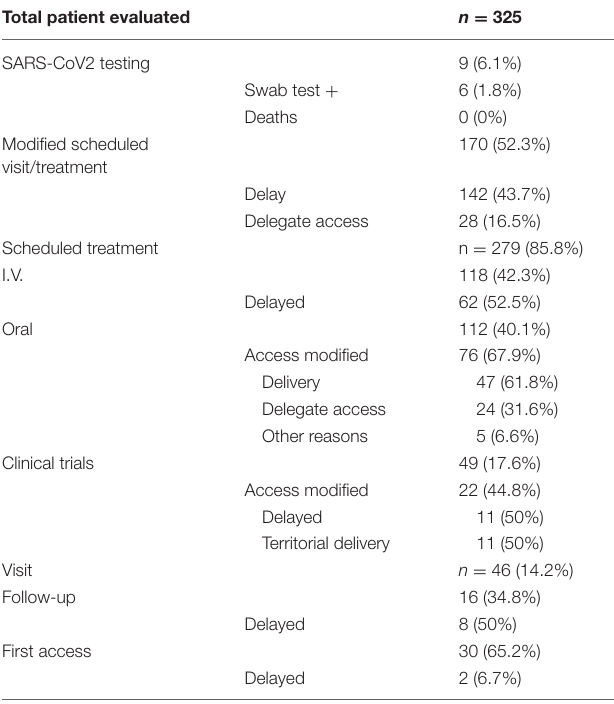
TABLE 3 | Results of multilevel containment measures for COVID-19. Total patient